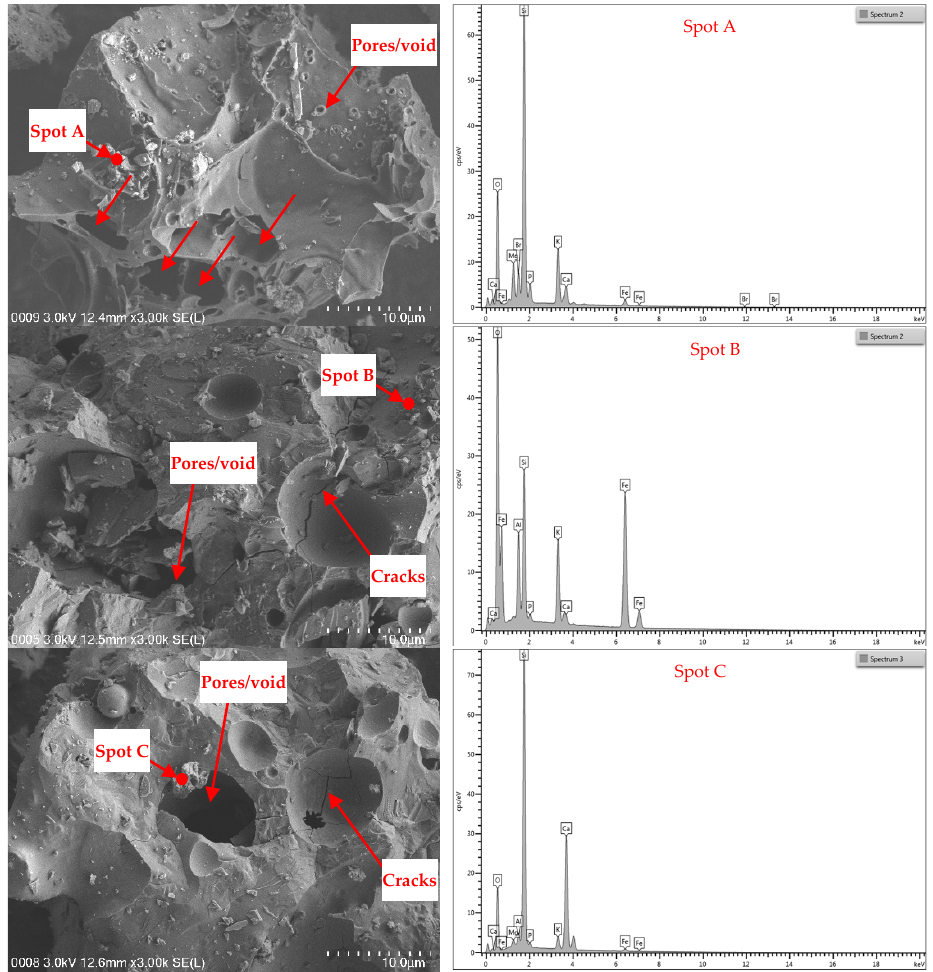
Figure 12. FESEM and EDX images of unheated and heated OPBC aggregates: Heated OPBC at ambient temperature ( top row ); Heated OPBC at 600 °C ( middle row ); and, Heated OPBC at 1000 °C ( bottom row ).